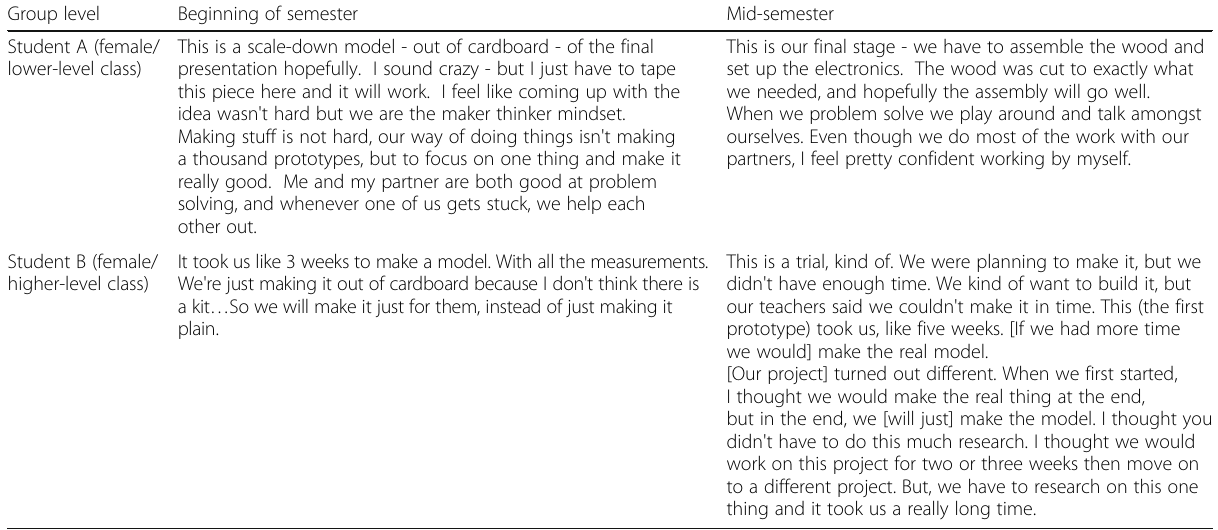
Table 5 Exemplary student quotes demonstrating self-efficacy trends Group level Beginning of semester Mid-semester Student A (female/ lower-level